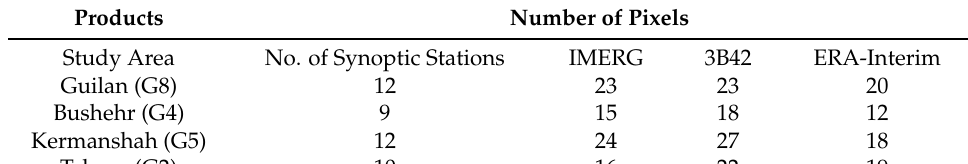
Table 2. Number of stations and pixels in each area.